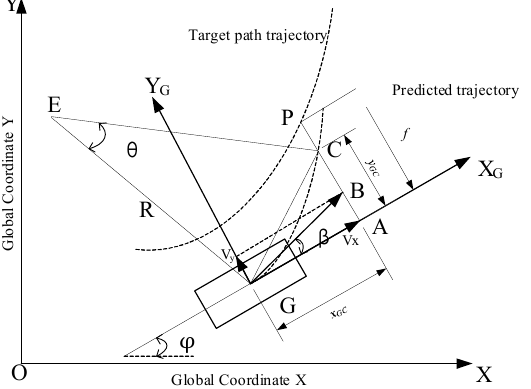
Figure 2. Steady-state transverse pendulum angular velocity with single point preview model.